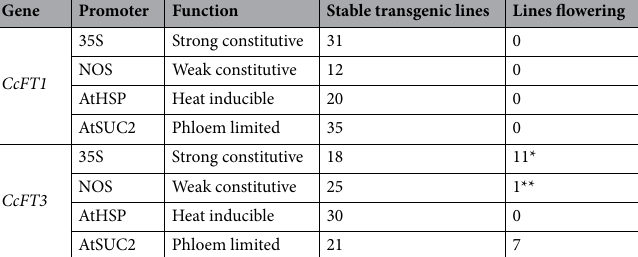
Gene Promoter Function Stable transgenic lines Lines